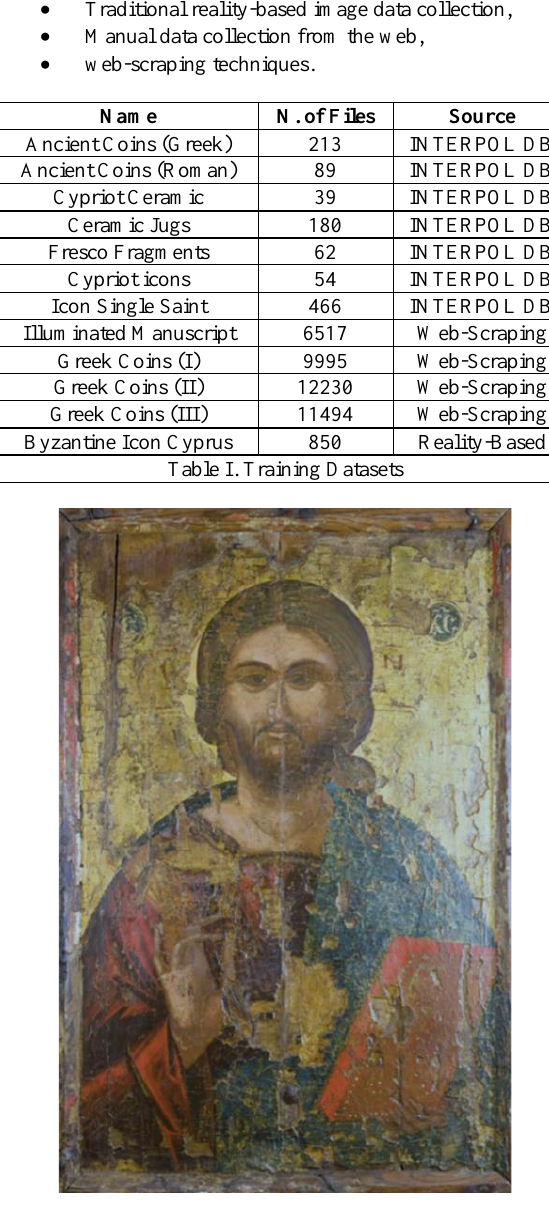
Figure 2. Training Dataset, Icon